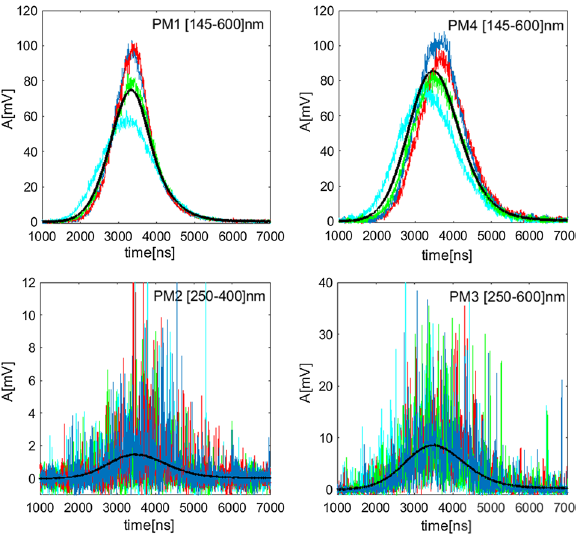
Fig. 16 Example of secondary scintillation signals recorded in the 145–600 nm range (upper plots), 250–400 nm (bottom-left) and 250– 600 nm (bottom-right). The average waveform obtained for 10,000 evts is shown in black (thick line). The events were taken at 10 bar, with 4.0 kV applied at the anode and 50 V/cm/bar in the drift region. Due to the increased diffusion and extended ionization trails, signals become wider as pressure decreases, and complicates the analysis and geomet- rical corrections below 3 bar. (Amplitudes are not directly comparable as the PM bias is different in each case)